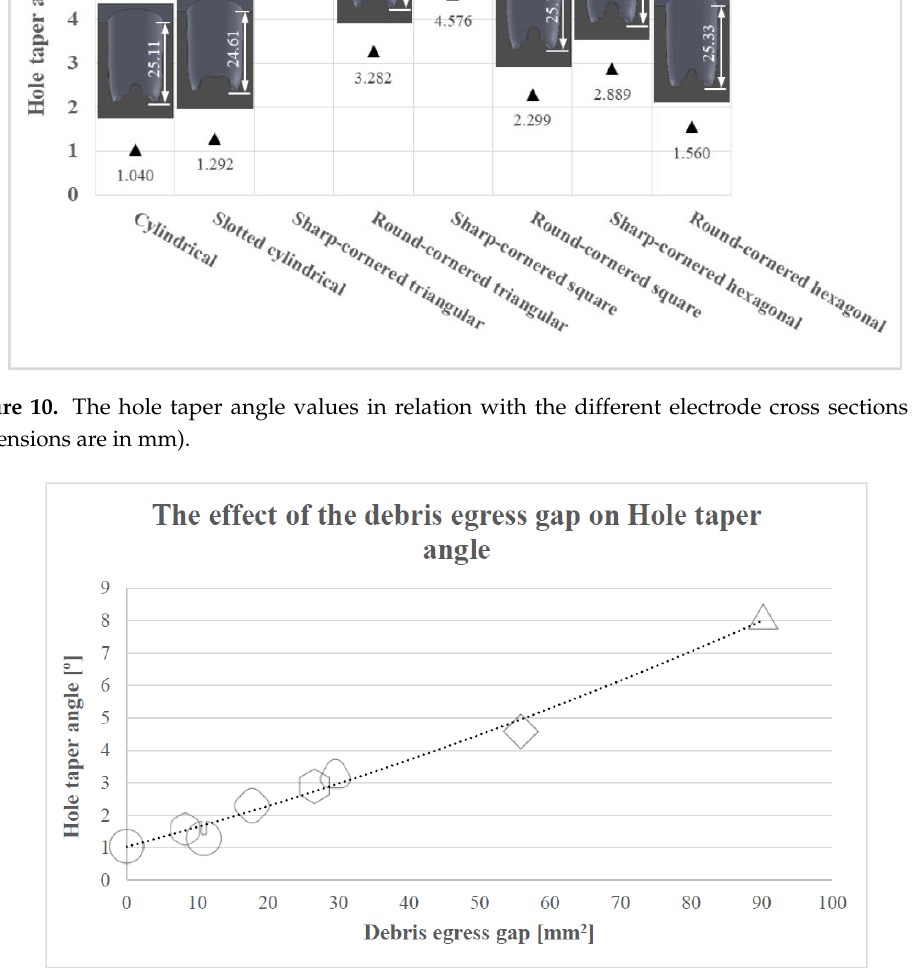
Figure 10. The hole taper angle values in relation with the different electrode cross sections (the dimensions are in mm).